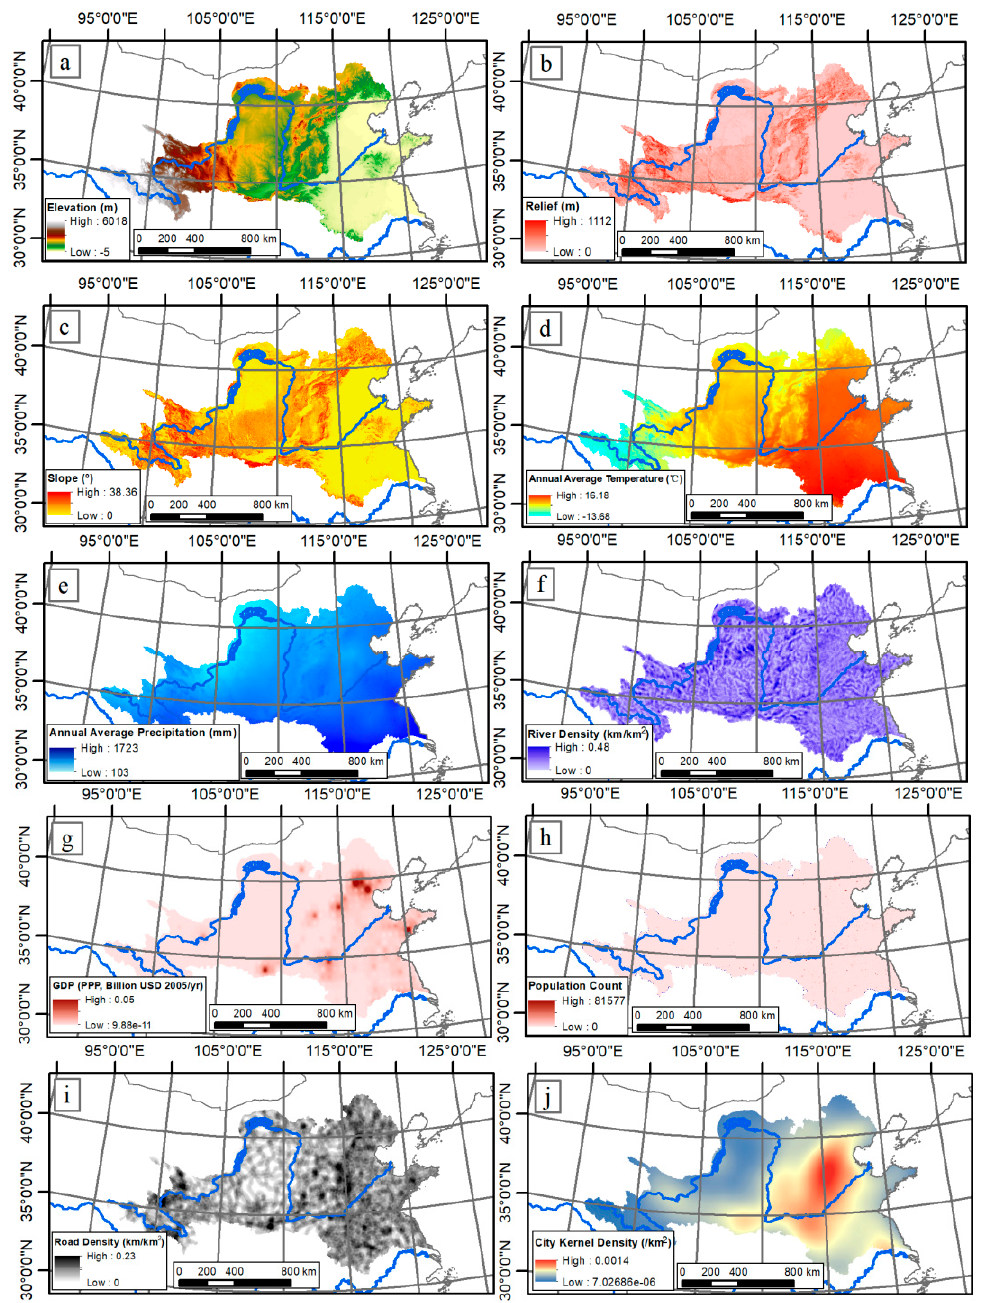
Figure 4. Impact factors considered in land cover prediction. ( a ) Elevation; ( b ) relief; ( c ) slope; ( d ) annual average temperature; ( e ) annual average precipitation; ( f ) river density; ( g ) GDP; ( h ) population; ( i ) road density; ( j ) city kernel density. We have considered as many natural and socio-economic factors as possible based on the availability of the data.